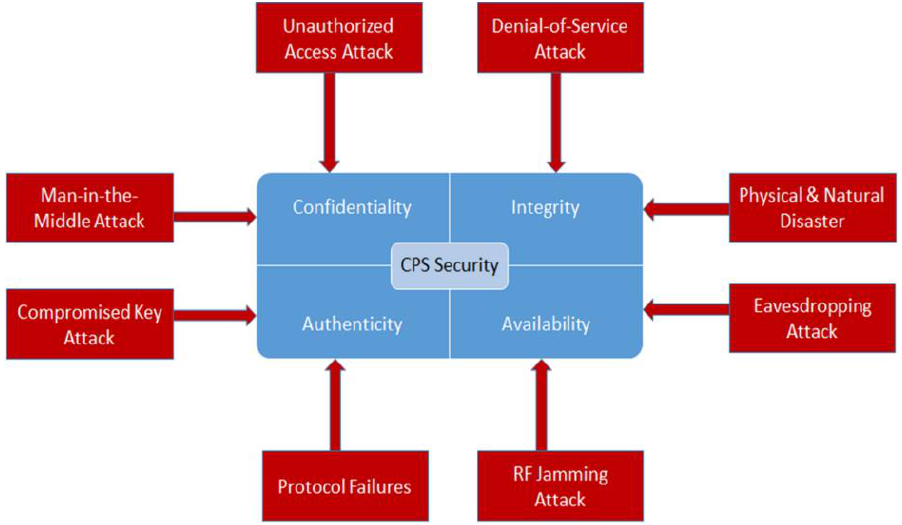
Figure 3. Security goals and threats.